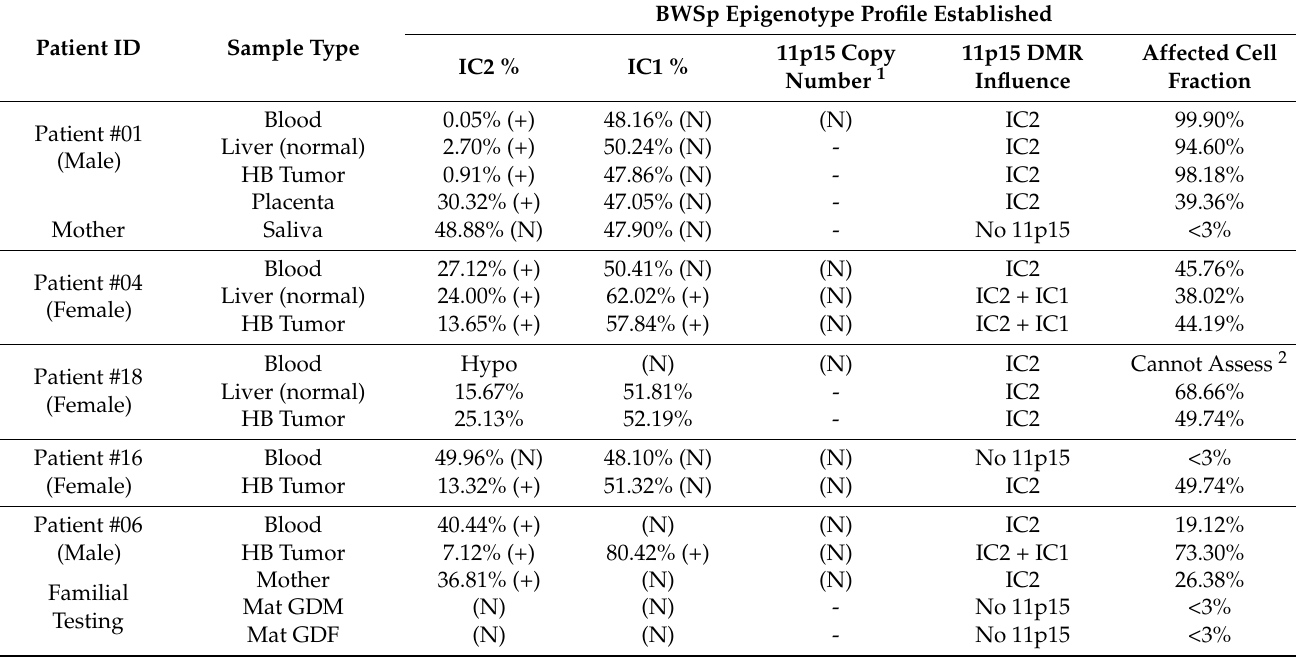
Table 13. 11p15 Epigenotype profiles associated with hepatoblastoma (HB) and IC2